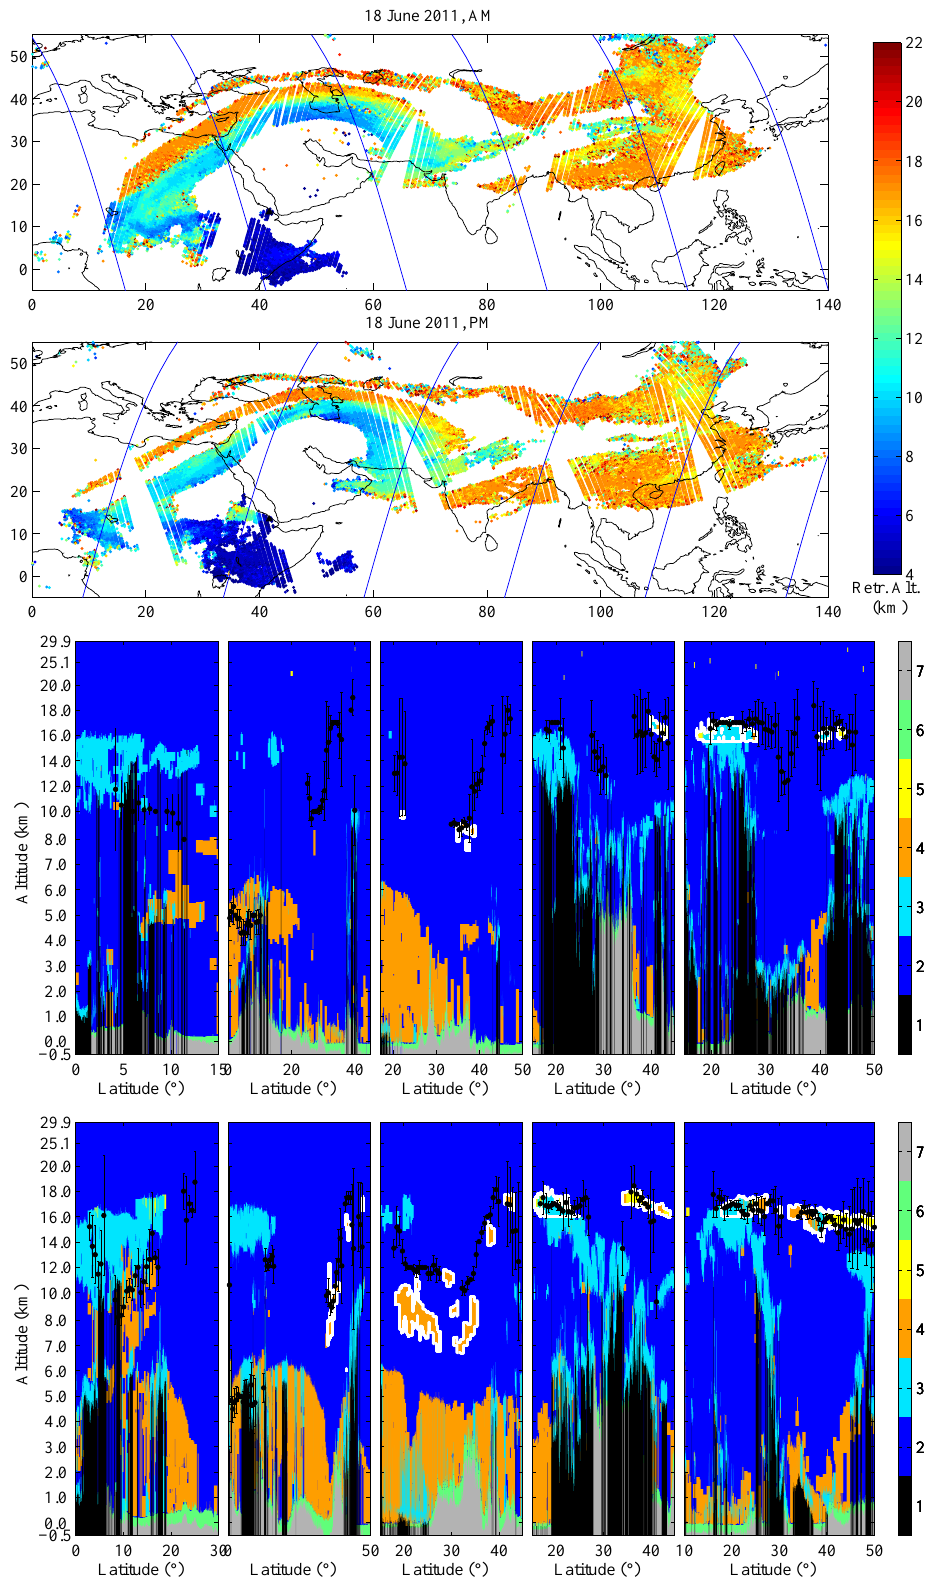
Fig. 9. Same as Fig. 6 for 18 June